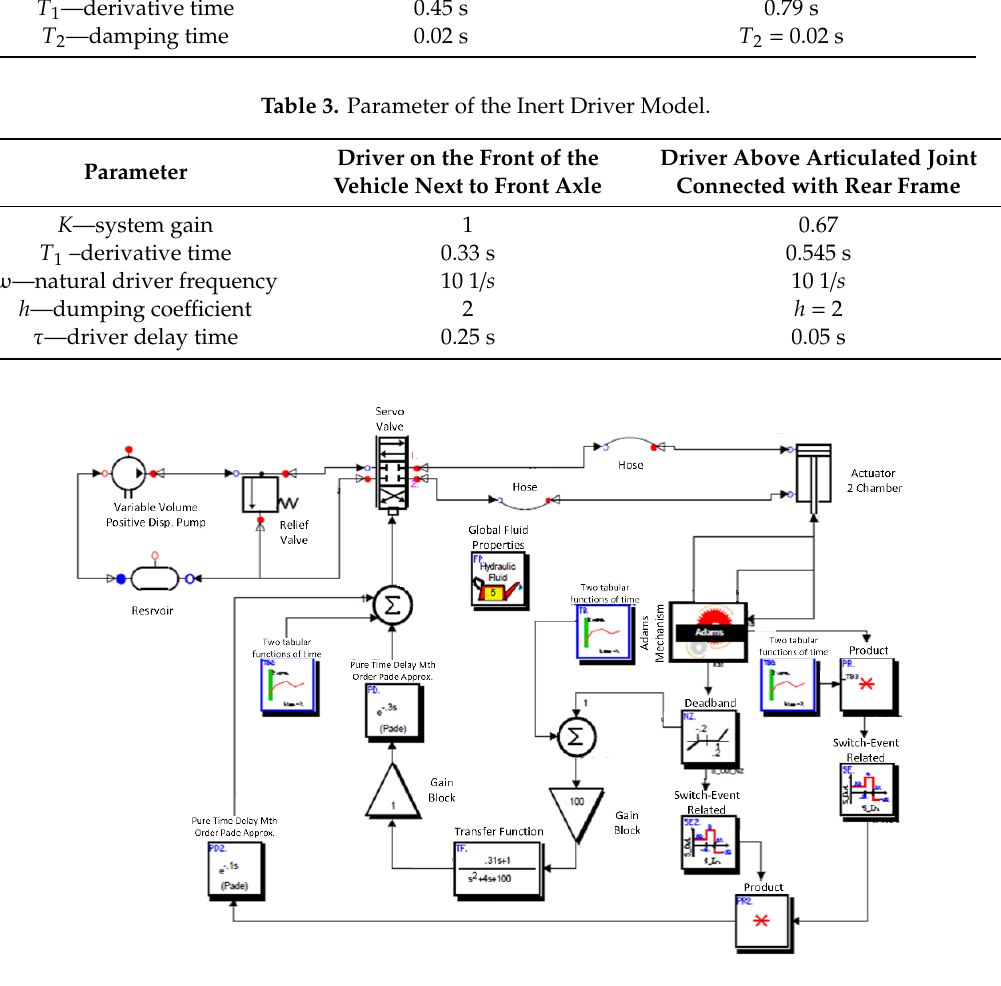
Table 2. Parameter of Anticipative Driver Model.